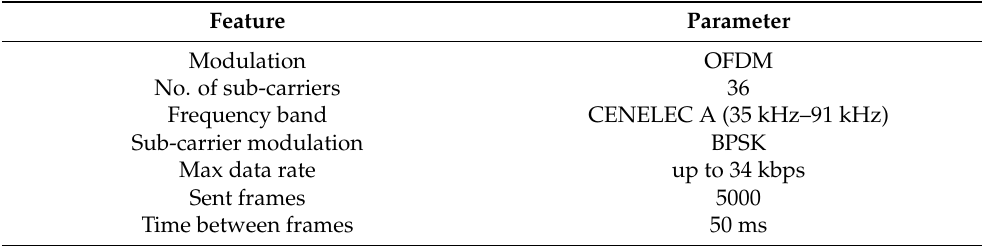
Figure 7. Experimental test bench to measure the active part of the model. Table 1. PHY layer specifications of the G3-PLC modems considered in this work.